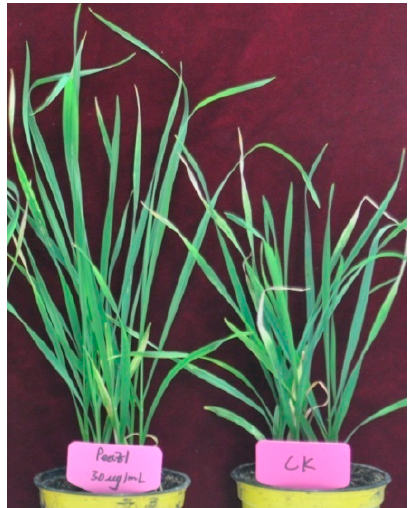
Table 3. Electrical penetration graph (EPG) parameters of Schizaphisgraminum in 6 h feeding time. Parameters of EPG Control ( n = 22) PeaT1 Treatment ( n = 22) p Value Time to 1st probe from start of EPG (min) 4.20 ± 0.64 0.04 Duration of nonprobe period before the 1st E1 (min) 18.11 ± 2.22 Time from 1st probe to 1st E1 (h) Time from start of EPG to 1st E1 (h)